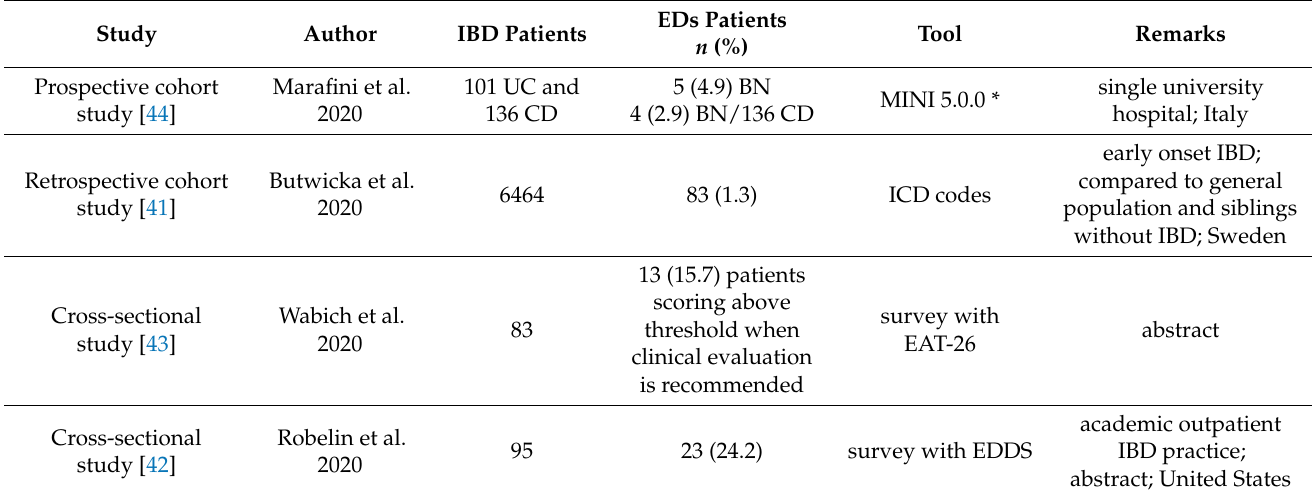
Table 1. Eating disorders in inflammatory bowel disease